Question: Name the type of graph shown.
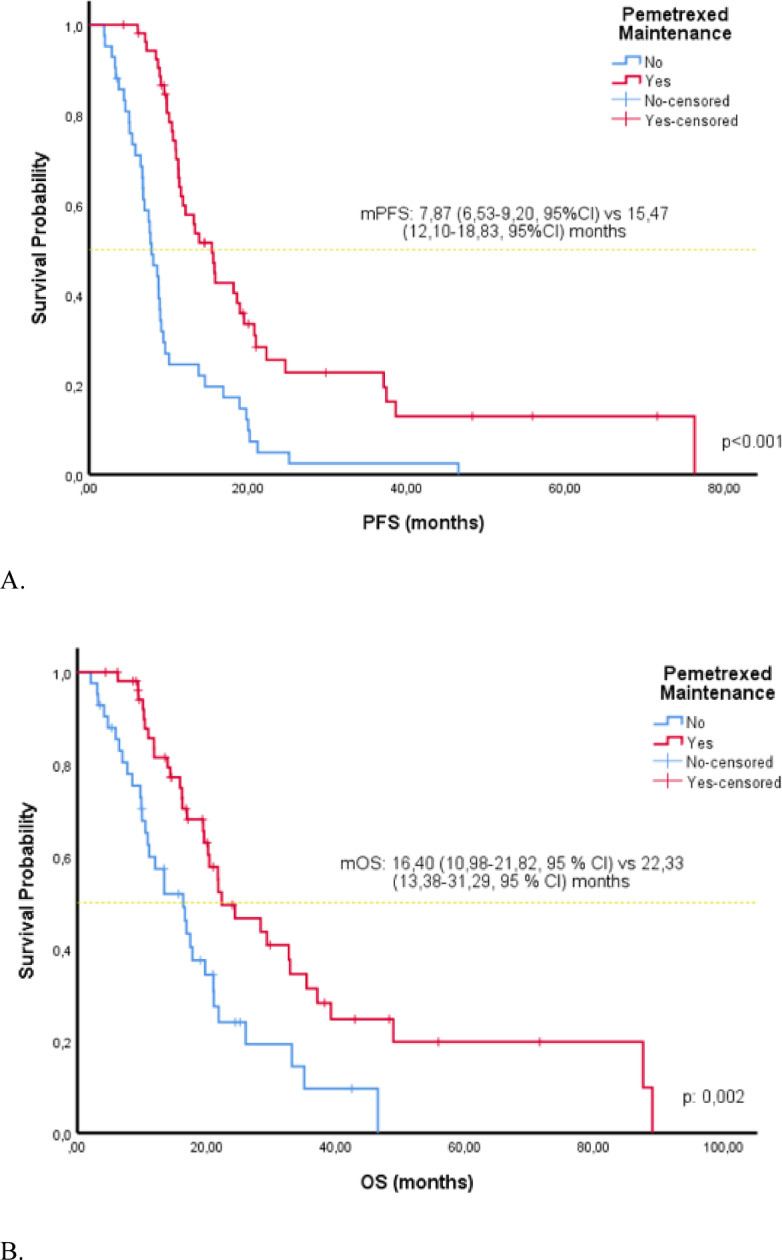
Answer: survival